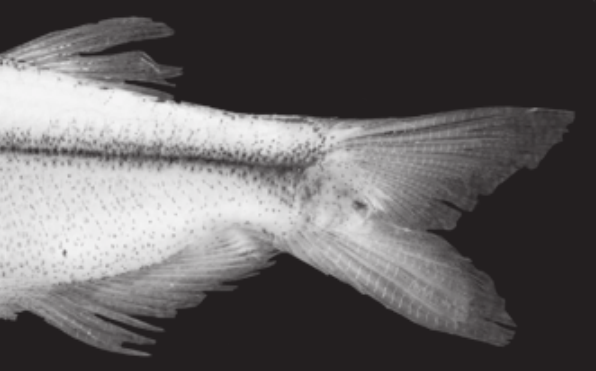
Fig. 2. Tyttocharax metae , paratype, IUQ 2343, adult male, 18.4 mm SL. Caudal peduncle and fin, left lateral view.